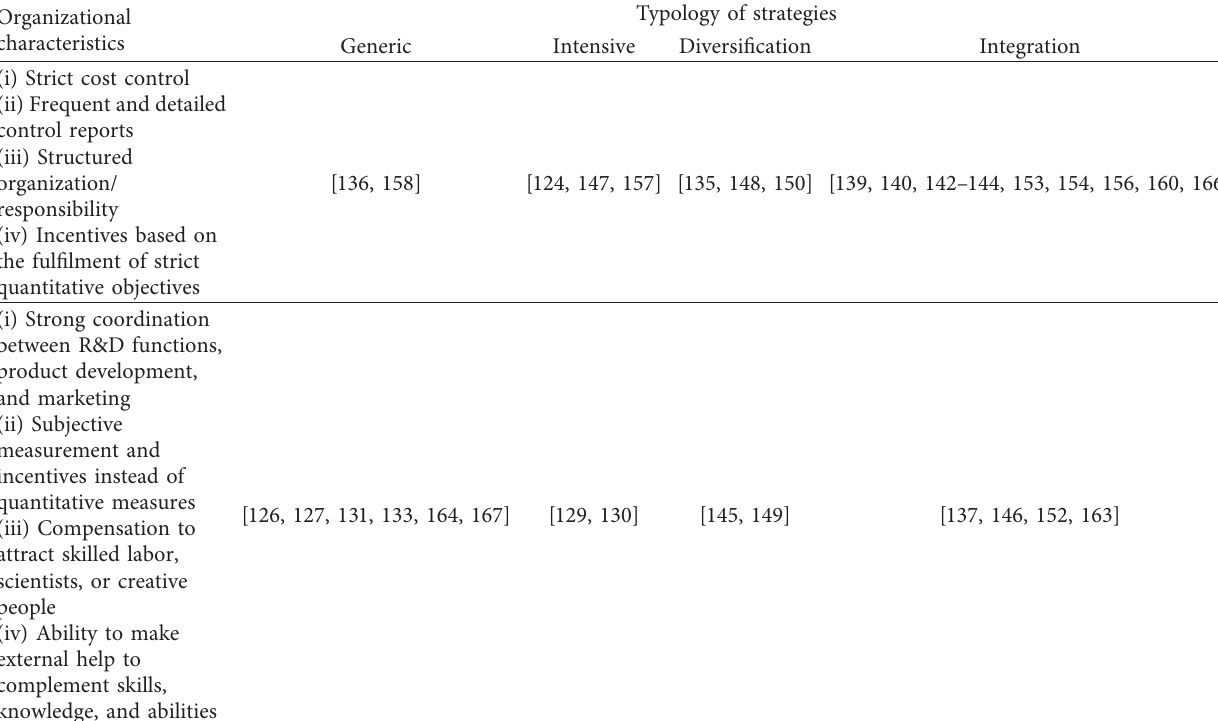
Table 7: Classification of investigations—strategy formulation